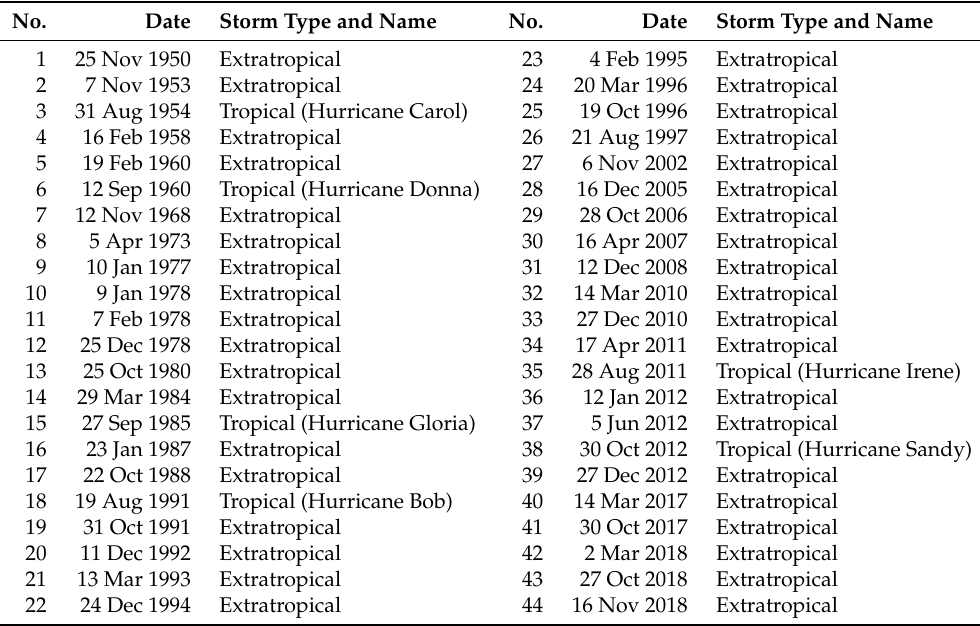
Table 2. List of severe historical storms in Long Island